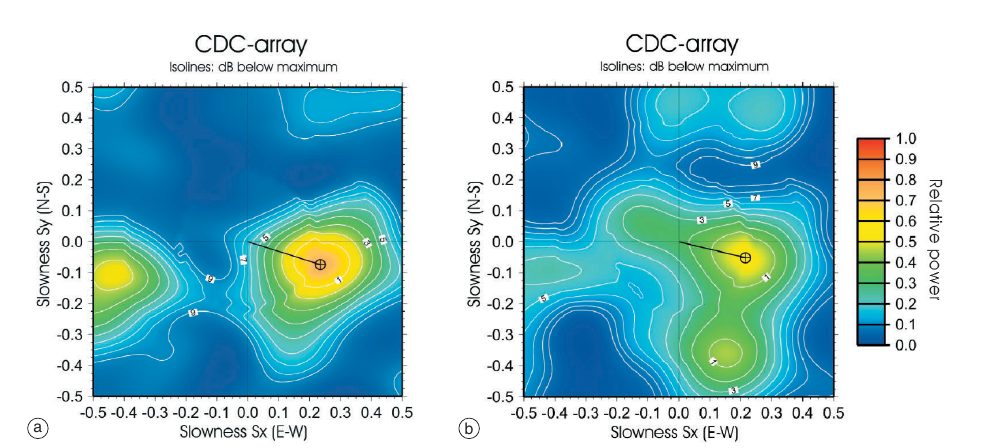
a Fig. 11a,b. a) F - k analysis performed on the E-W records of the S -phase. The maximum peak corresponds with an apparent velocity of v app = 4.05 km/s and a backazimuth of 107.5° (relative power = 0.74); b) f - k analysis per- formed on the N-S records of the S -phase. The maximum peak level (relative power = 0.52) is found for an ap- parent velocity v app = 4.52 km/s, reaching the array from a backazimuth of 103.5°.